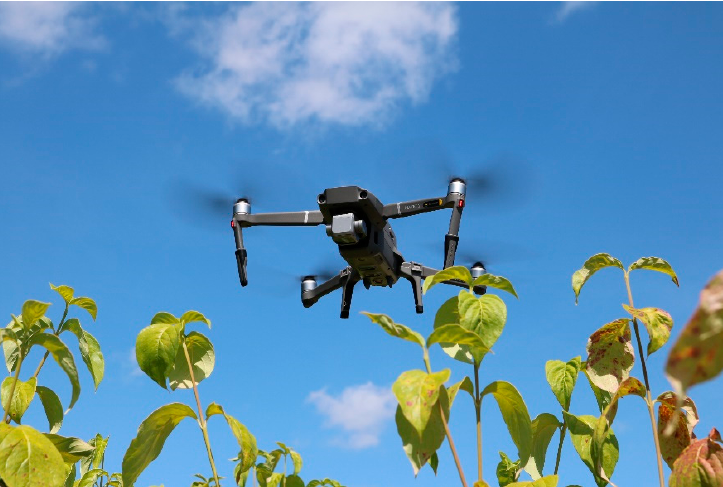
Figure 1. Example DJI Mavic 2 platform being used in a project at the Tennessee State University (TSU) Otis L. Floyd Nursery Research Center in McMinnville, TN involving automatic detection of biotic and abiotic stresses in nursery field productions. This unmanned aerial vehicle (UAV) platform will be equipped with a Raspberry Pi, 3D camera, and a multispectral camera to make up the unmanned aircraft system (UAS).